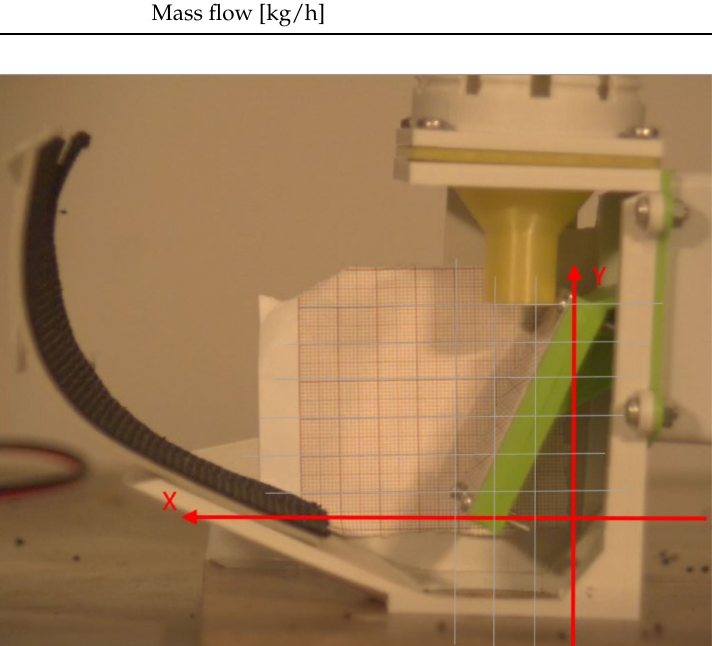
Figure 8. Axes of the coordinate system during determination of the grain point of collision with the sensor and the distance after the impact for the vertical tube (tilt 0 ◦ ).